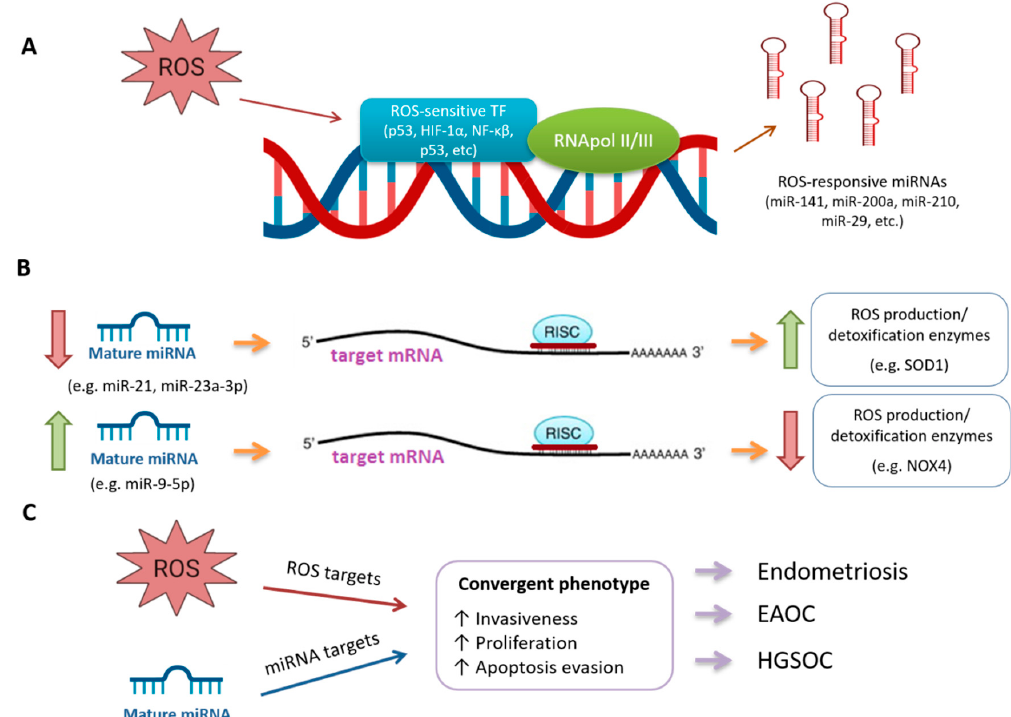
Figure 2. Schematic representation of the possible mechanisms of interplay between miRNAs and oxidative stress. ( A ) ROS can activate ROS-sensitive transcription factors to induce the transcription of specific primary miRNA (pri-miRNA) that will conduce to mature miRNAs; ( B ) The levels of a given miRNA inversely correlate with those of their target mRNAs, that could belong to ROS production/detoxification enzymes; ( C ) ROS and miRNAs can produce separate effects that converge in a common phenotype, leading to endometriosis, EAOC and HGOSC. Abbreviations: ROS, reactive oxygen species; TF, transcription factors; RNApol II/III, RNA polymerase II or III; HIF-1 α , hypoxia- inducible factor 1 α ; NF- κβ , nuclear factor κβ ; RISC, RNA-induced silencing complex; SOD1, superoxide dismutase 1; NOX4, NADPH oxygenase 4; EAOC, endometriosis-associated ovarian cancer; HGSOC, high-grade serous ovarian cancer.